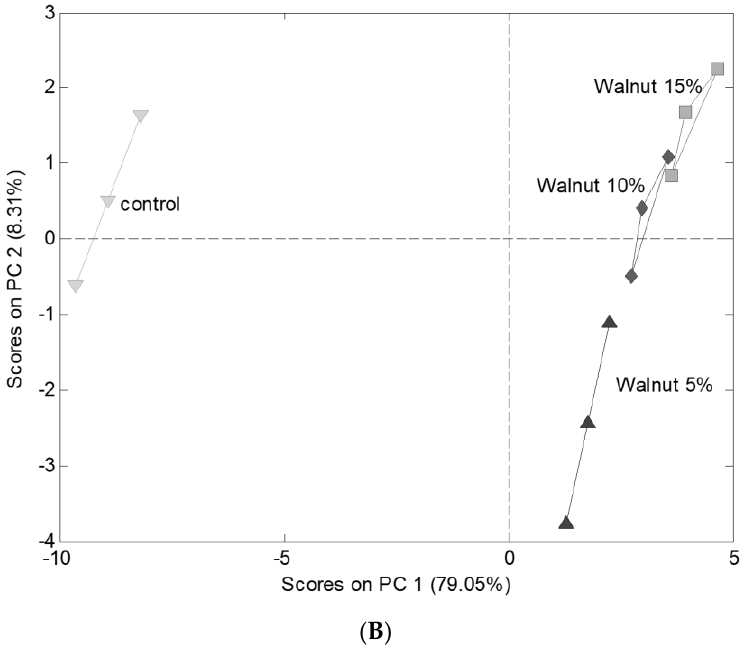
Figure 2. PCA plots ( A ) similarity map and ( B ) loading map obtained by principal components analysis of physicochemical, functional, sensory and fatty acids parameters of processed cheese con- taining 0, 5, 10, and 15% walnut